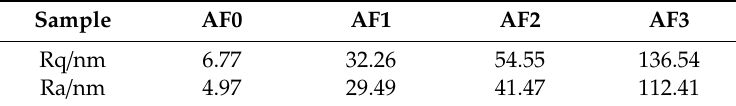
Figure 12. AFM image (3 × 3 µ m 2 ) of AF before and after modification. (( a ) AF0; ( b ) AF1; ( c ) AF2; ( d ) AF3). Table 5. Surface roughness of aramid fiber before and after processing.